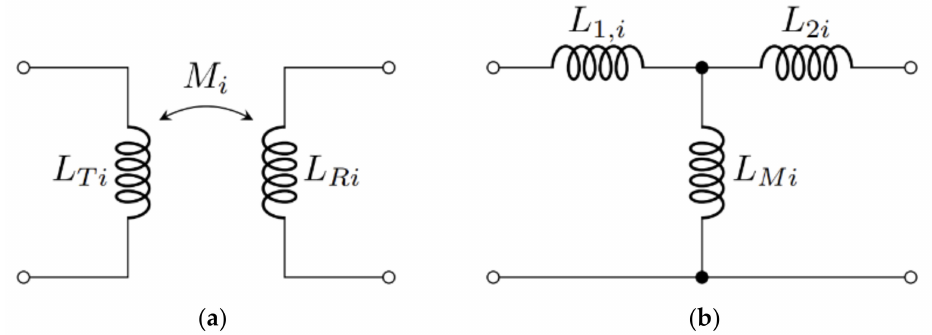
Figure 4. Equivalent model of the IPT coil. ( a ) Loosely coupled air transformer model. ( b ) Equivalent T model of an air transformer model.